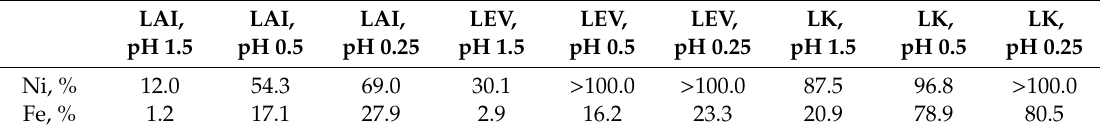
Table 4. Nickel and iron yields to solution in acid leaching test of LAI, LEV, and LK laterite in pH 0.25, 0.5 and 1.5. Parameters used in the experiments: 90 ◦ C, S / L = 30%, 800 rpm. pH was maintained by H 2 SO 4